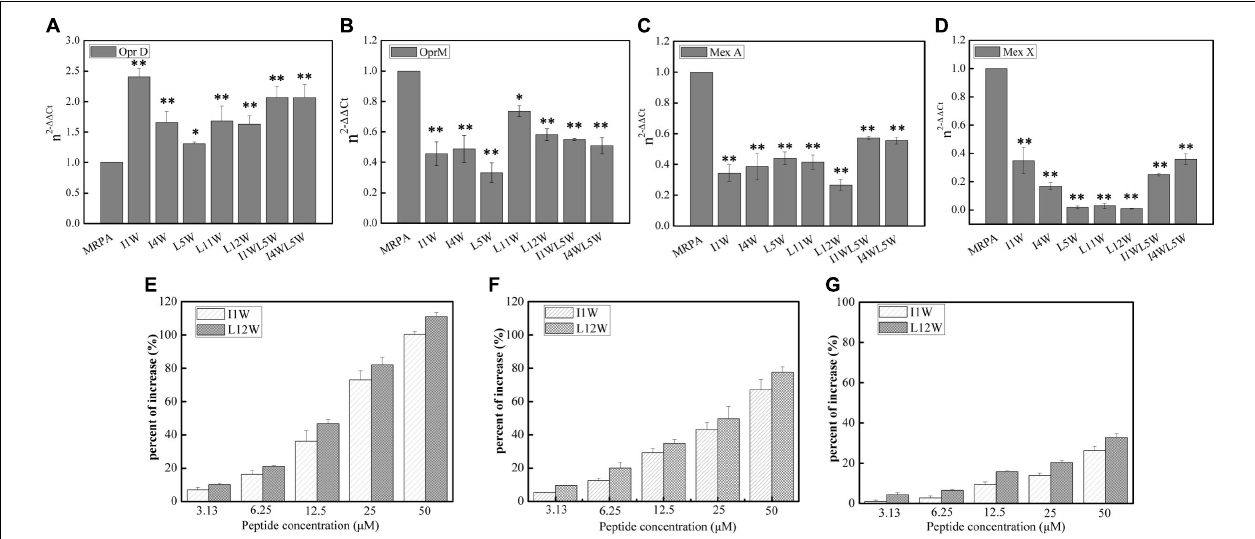
FIGURE 8 | Effect of the Trp-containing peptides on the antibiotics content in MRPA0108 cells. (A–D) Relative expression of porin gene OprD (A) , efflux pump gene OprM (B) , MexA (C) , and MexX (D) was measured by real-time qPCR. Fold changes of gene expression were normalized to the level of rpsL gene and quantitated relative to gene expression of control was normalized to 1 using the comparative Ct method. (E–G) The content of antibiotics ceftazidime (E) , piperacillin (F) , and levofloxacin (G) in MRPA0108 cells treated with the Trp-containing peptides was measured by HPLC. Results represent the average of at least four independent experiments SD (* P < 0.05 and ** P <